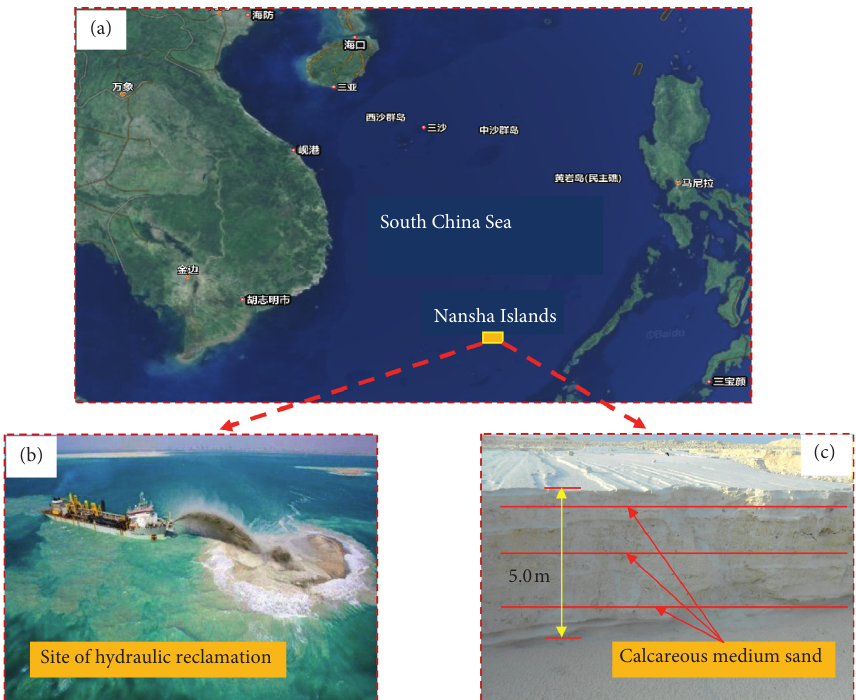
Figure 1: Location of the study area. (a) Location of Nansha Islands; (b) site of hydraulic reclamation; (c): sampling sites